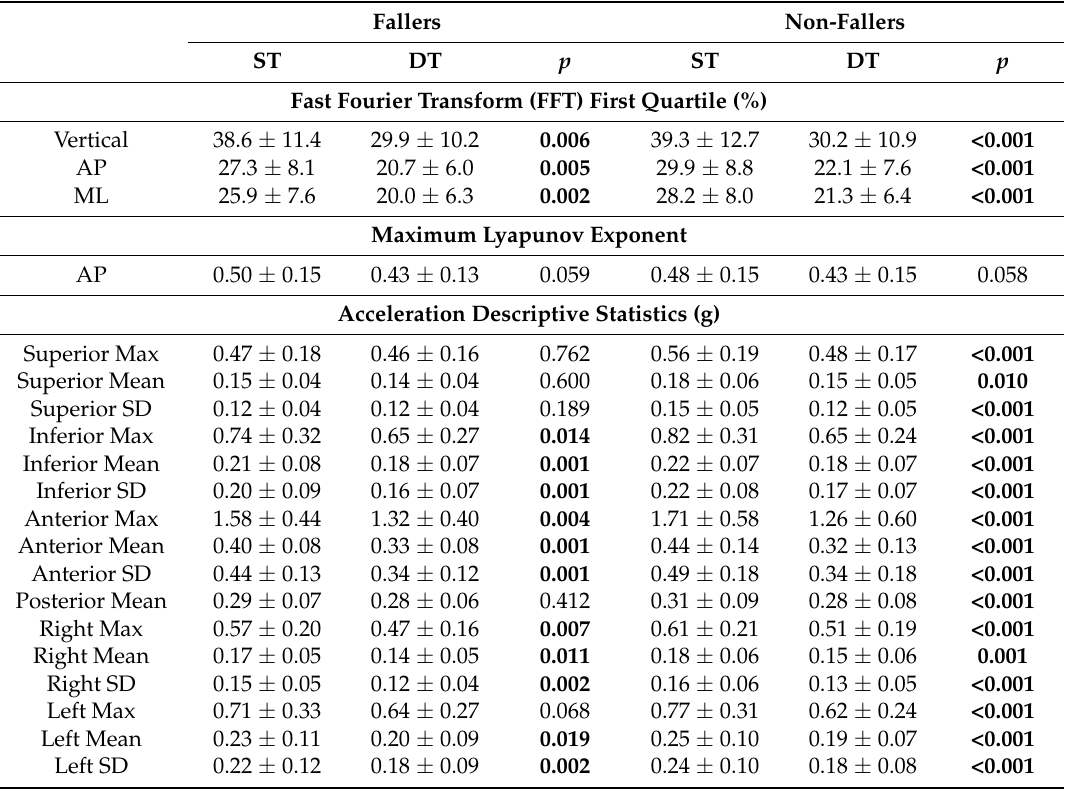
Table 4. Means and SD for right shank accelerometer variables with a significant ( p < 0.05) mixed-design ANOVA result (Supplementary Table S4). Bold p -values indicate significant differences between ST and DT conditions after correction for multiple